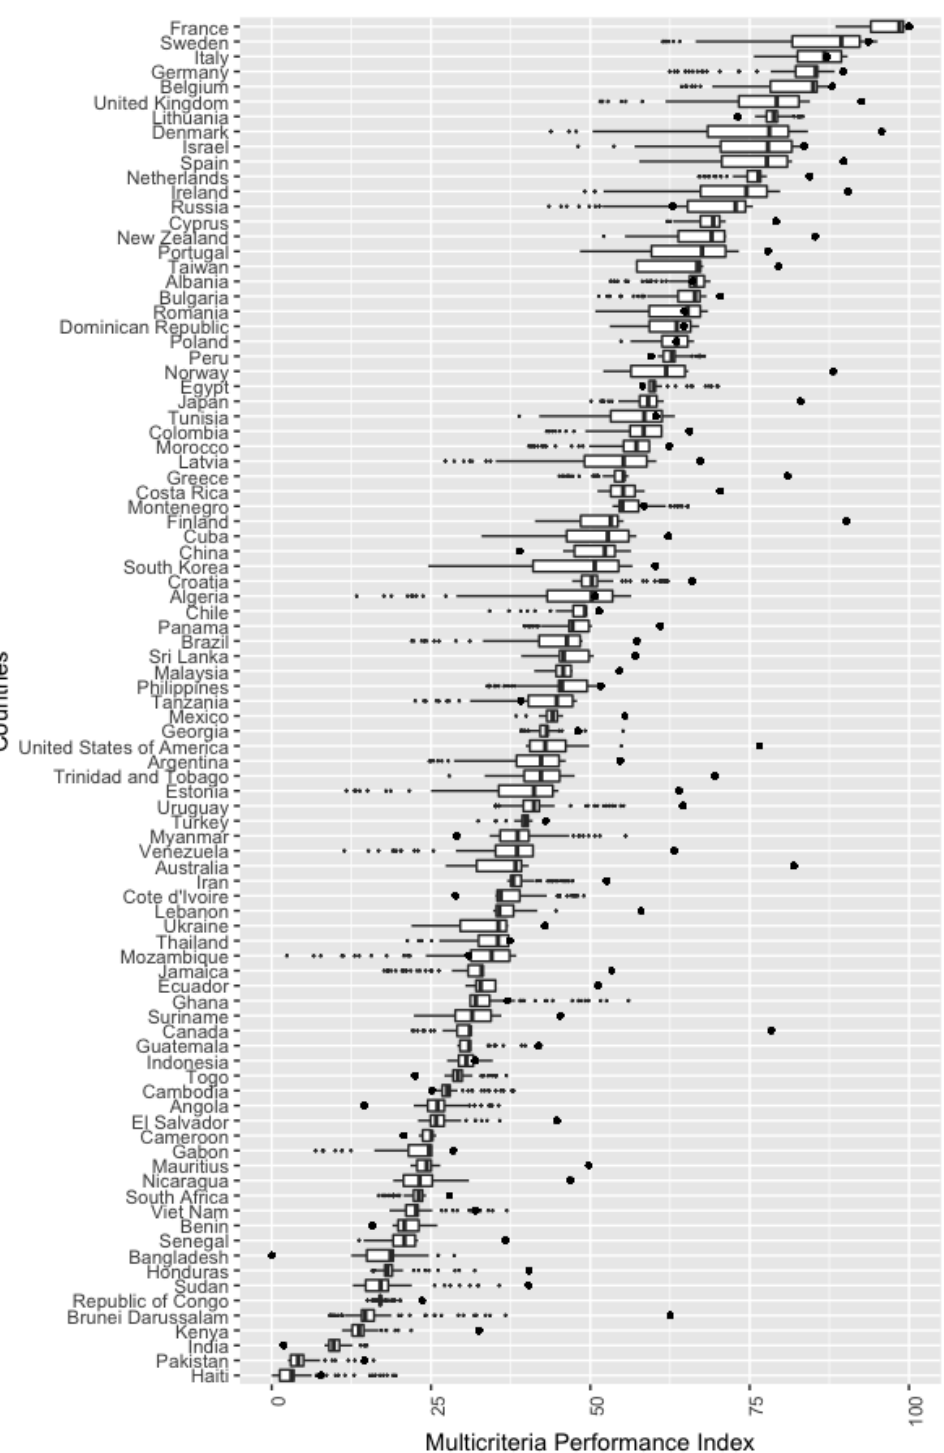
Figure 3. Multicriteria Environmental Performance (EPI) values according to the λ values used in the goal programming model. The EPI score from [9] is represented by